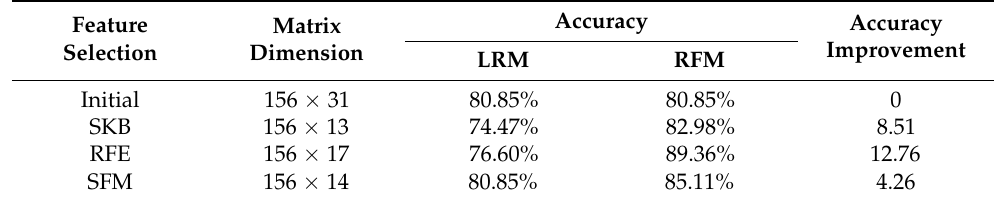
Table 4. Modeling results of four feature selection methods for saline–alkali-tolerant rice varieties.